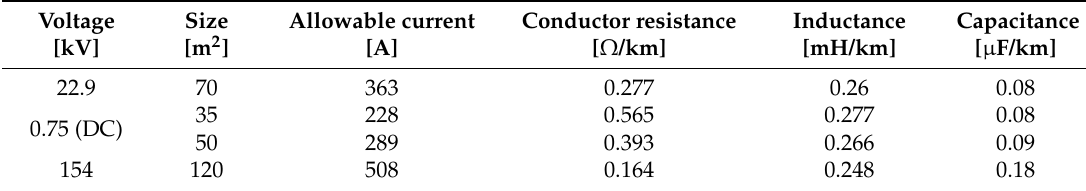
Table 2. Numerical cable parameter in hybrid generation system